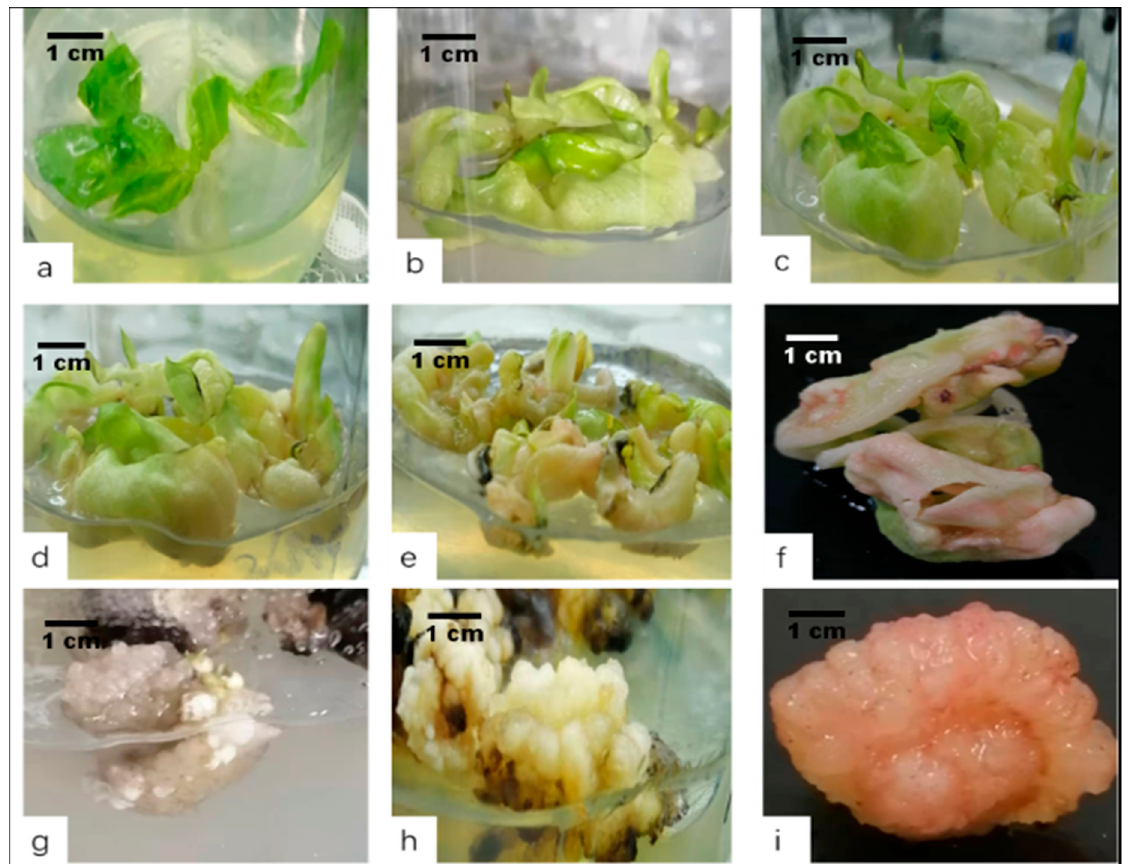
Figure 3. The procedure for embryogenic callus induction from konjac leaves as an explant. ( a ) Leaf explants were taken from sterile seedlings. ( b ) Ten days after culture, the explants faded and thickened. The embryogenic callus induction preparation period. ( c ) Fourteen days after culture, the edge was further enlarged and thickened. ( d ) The leaves became light red after 20 days of culture in a culture medium. ( e ) The colour became darker after 25 days of culture, and the surface appears granular. ( f ) A zoomed-in image from ( e ). ( g ) Type I calli formed after 28 days of culture and were transparent, brittle, and undifferentiable. ( h ) Type II calli formed after 28 days of culture and were yellow-white, loose, granular, compact in structure, and differentiable. ( i ) Type III callus formed after 28 days of inoculation and culture; were greenish or pink, compact in structure, granular, and highly differentiable; and had a high conversion rate.